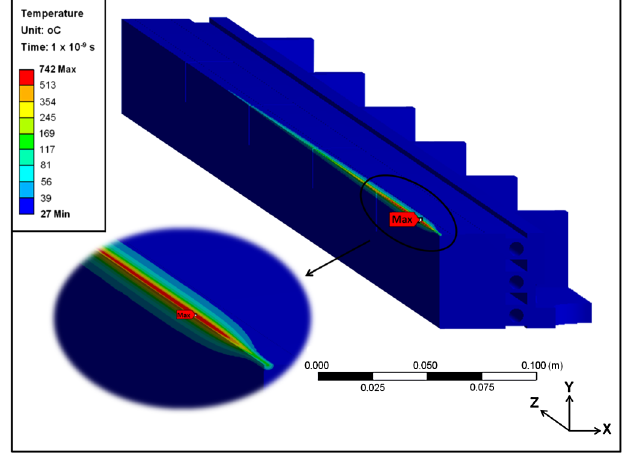
FIG. 12. Temperature distribution provoked by the nominal lead ion beam impact at 1 ns. The melting temperature of INERMET ® 180 ( ∼ 1343 °C) is not exceeded in any region in this case. A detailed view is shown in the inset.